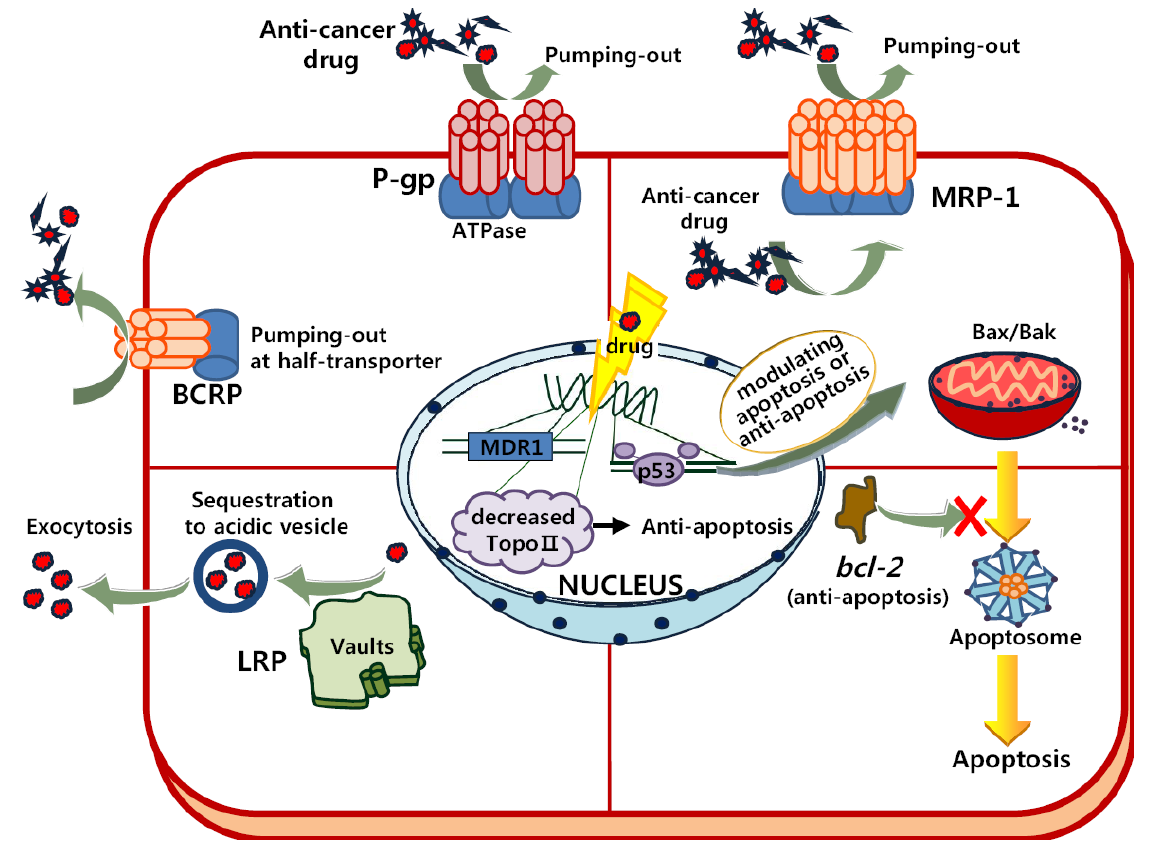
Figure 1. Drug-resistance mechanisms (such as P-gp, MRP, BCRP, LRP, p53, bcl -2, and TopoII) in tumor cells. See text for